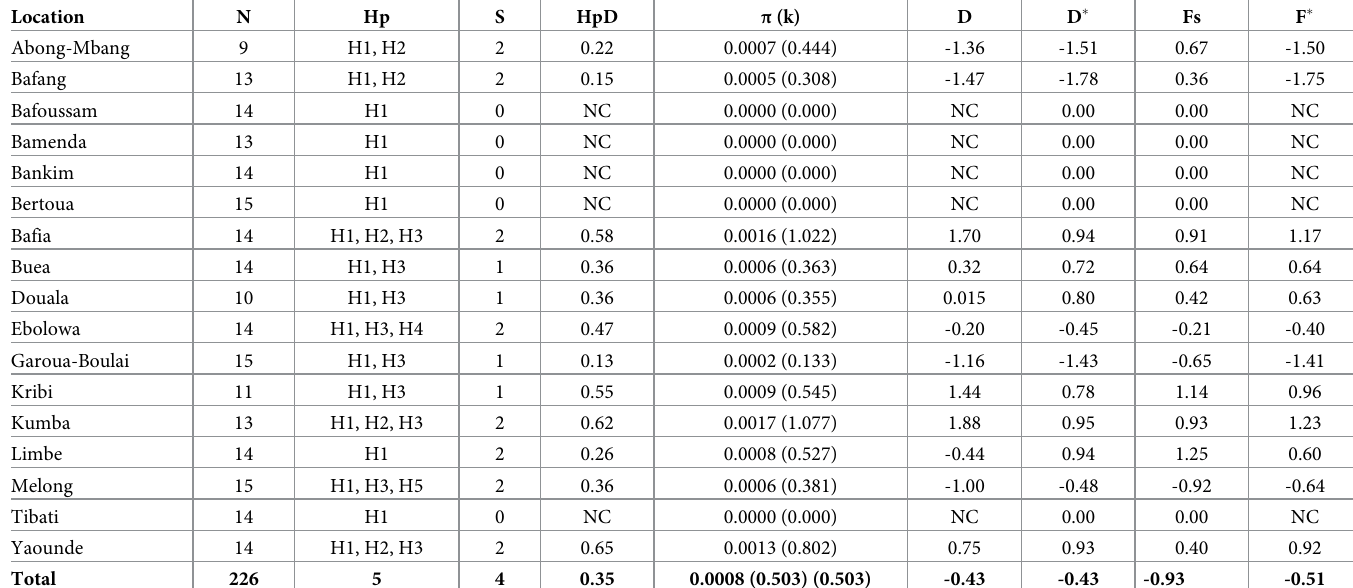
Table 4. Genetic diversity indices in Aedes albopictus from